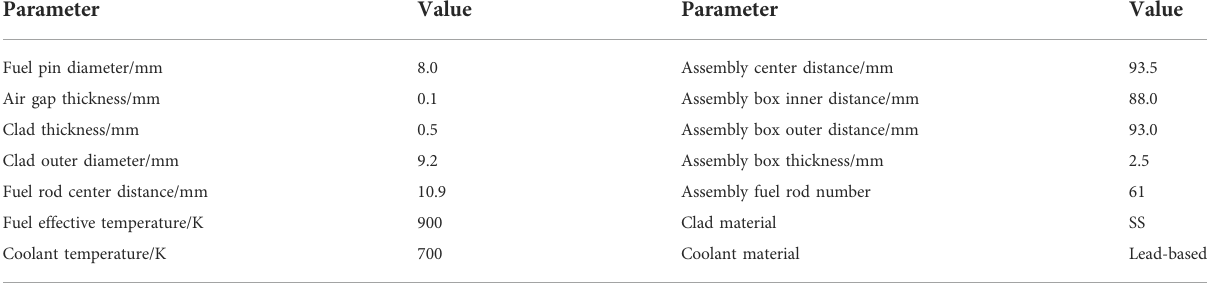
TABLE 2 Main design parameters of the